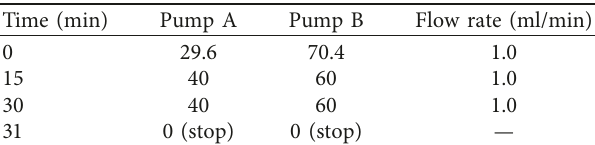
Table 4: Solvent gradient conditions of the high-performance liquid chromatography for saponin quantification.